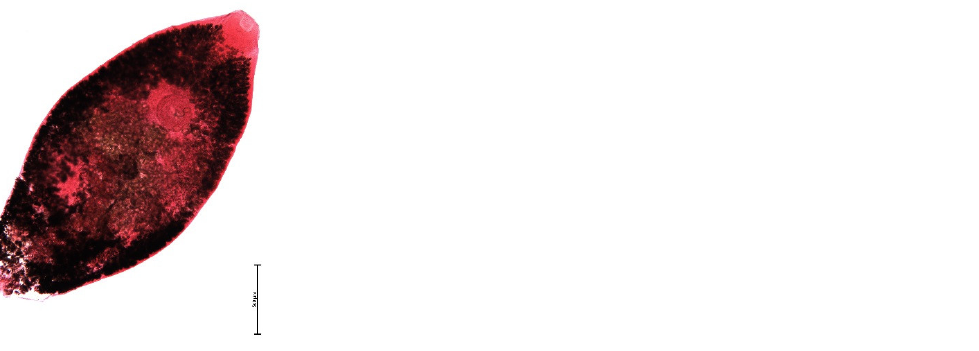
Figure 4. Plagiorchis arvicolae. Yolk glands fill most of the body. In unstained fresh specimens the trematode reminds an apple seed. Bar: 500 μm.